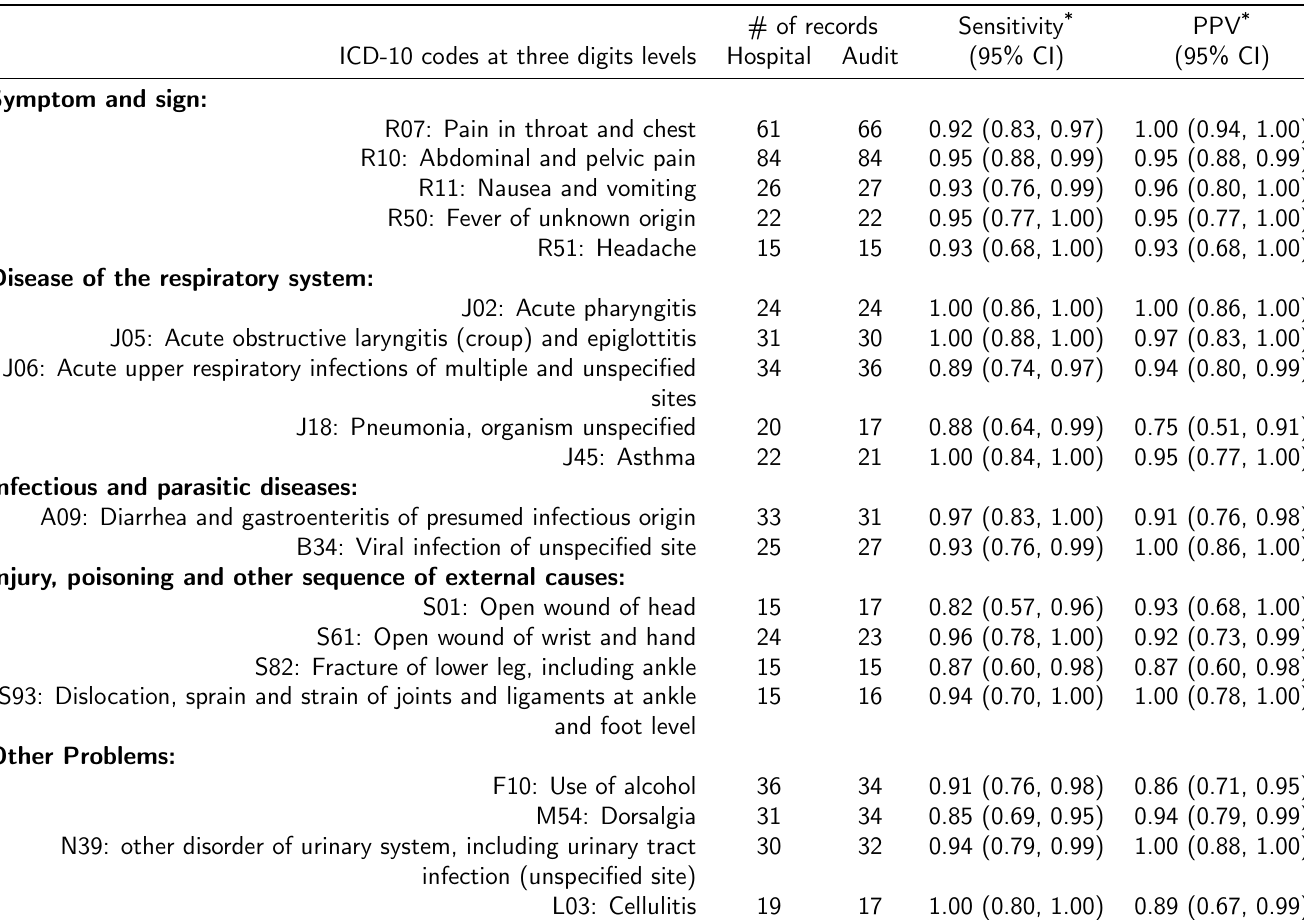
Table 2: Agreement on top 20 frequently used diagnosis codes